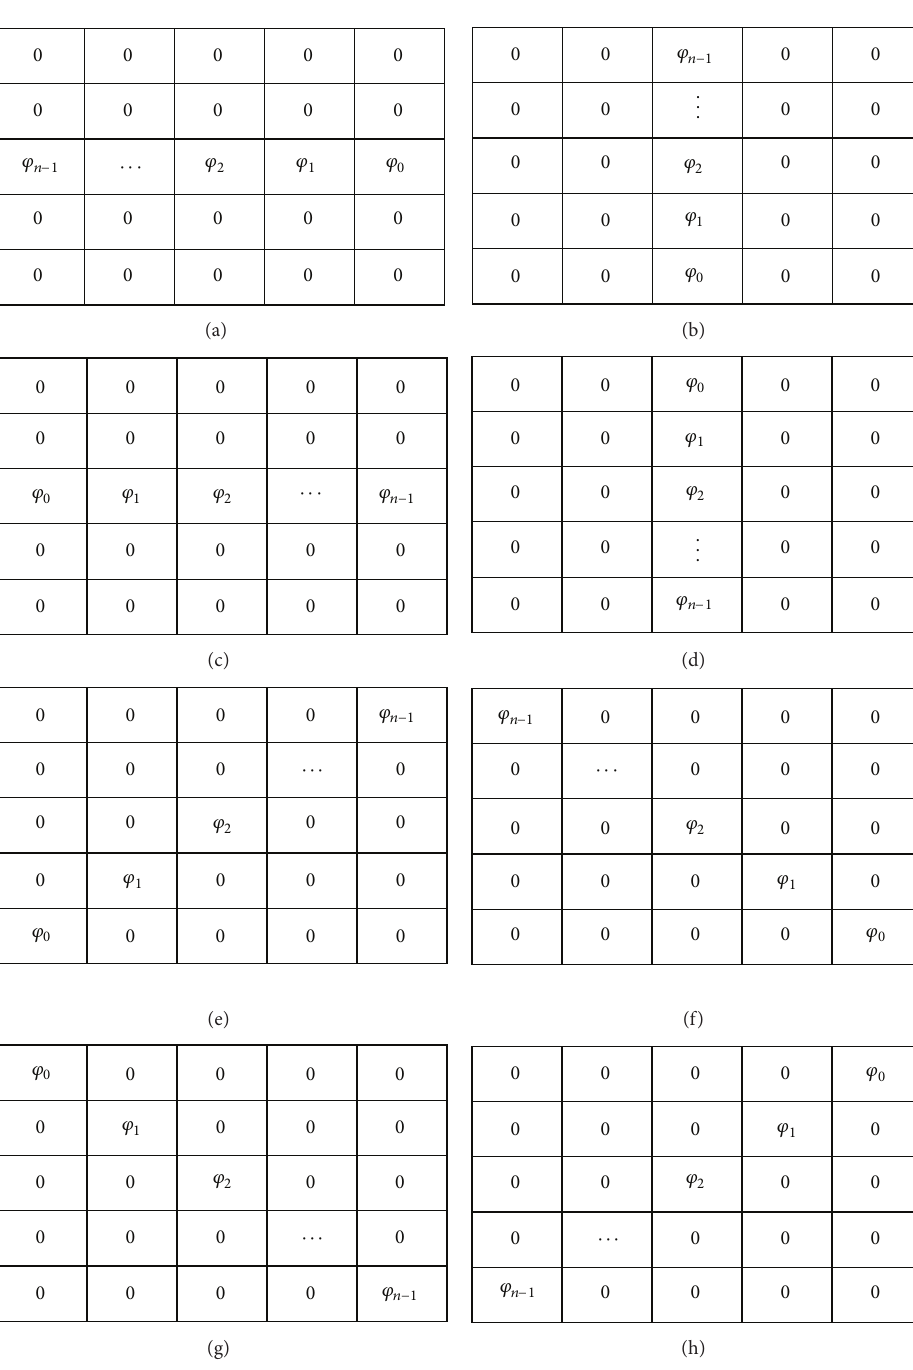
Figure 1: Fractional masks at 180 ∘ , 90 ∘ , 0 ∘ , 270 ∘ , 45 ∘ , 135 ∘ , 315 ∘ , and 225 ∘